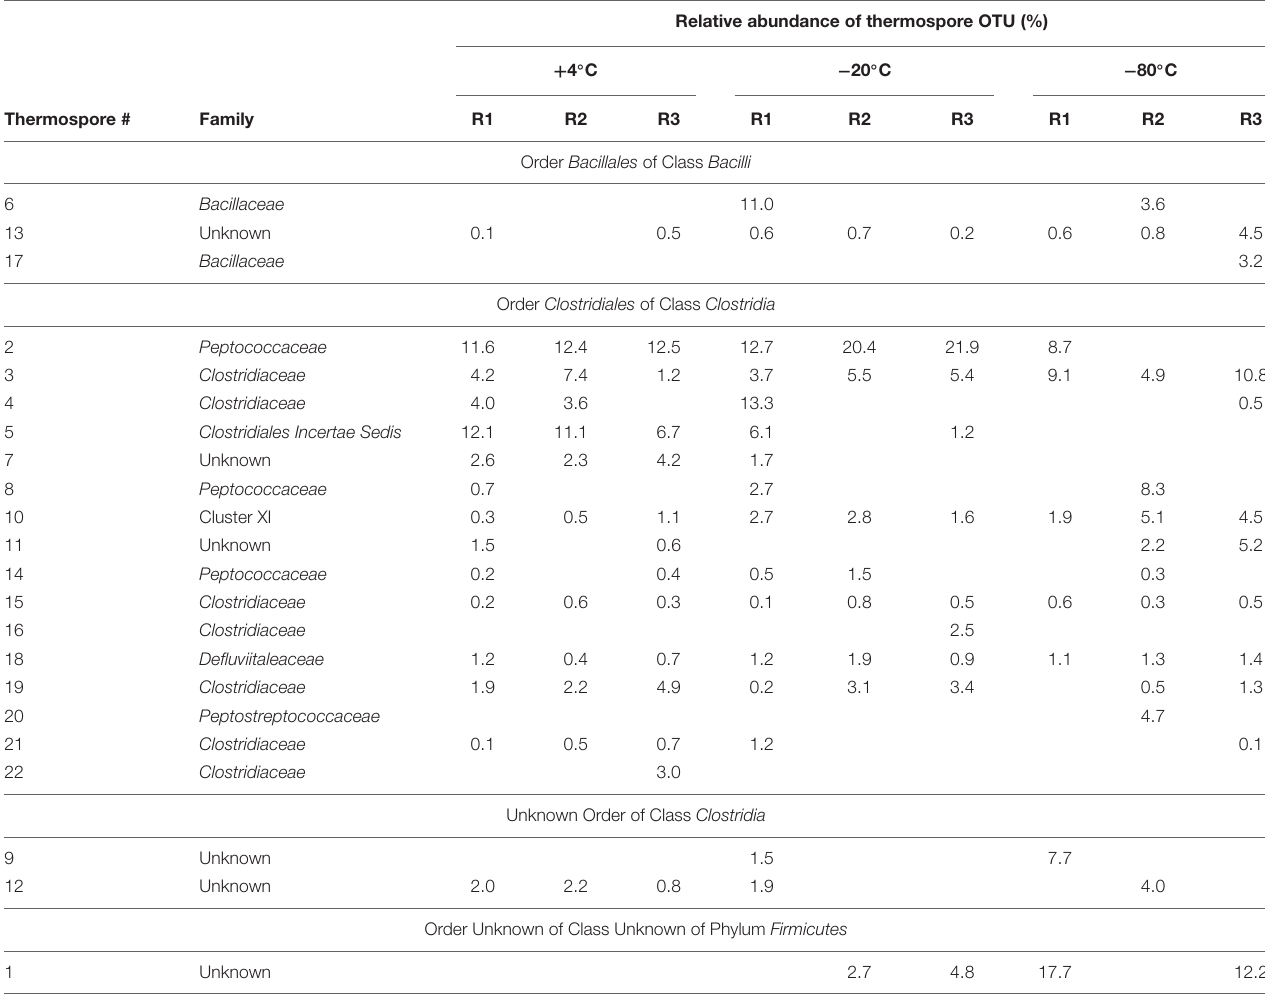
TABLE 3 | Individual thermospore OTU relative sequence abundance detected after pretreatment at + 4 ◦ C, − 20 ◦ C, and − 80 ◦ C and incubation for 7 days at + 50 ◦ C. Relative abundance of thermospore OTU